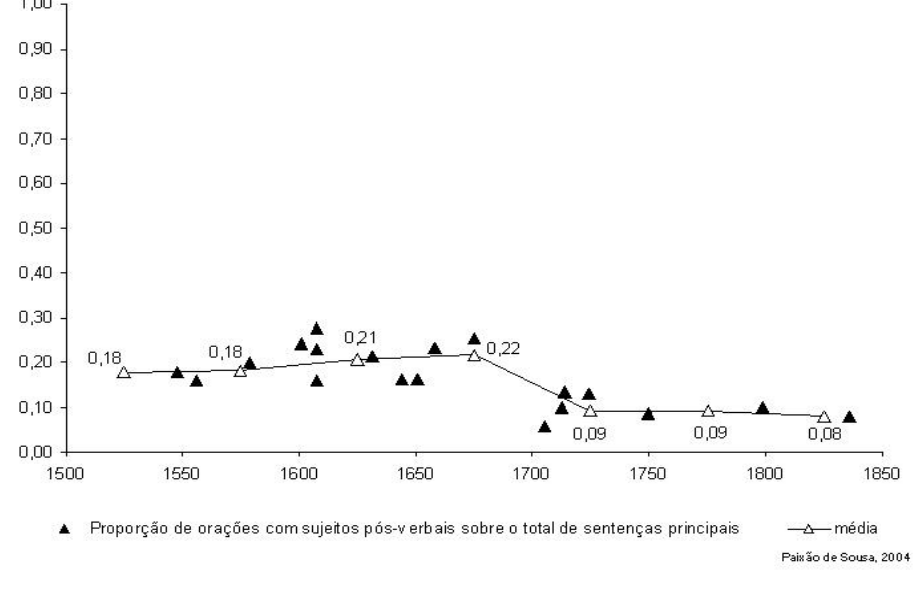
Figure 6 : Proportion of VS constructions in matrix affirmative clauses